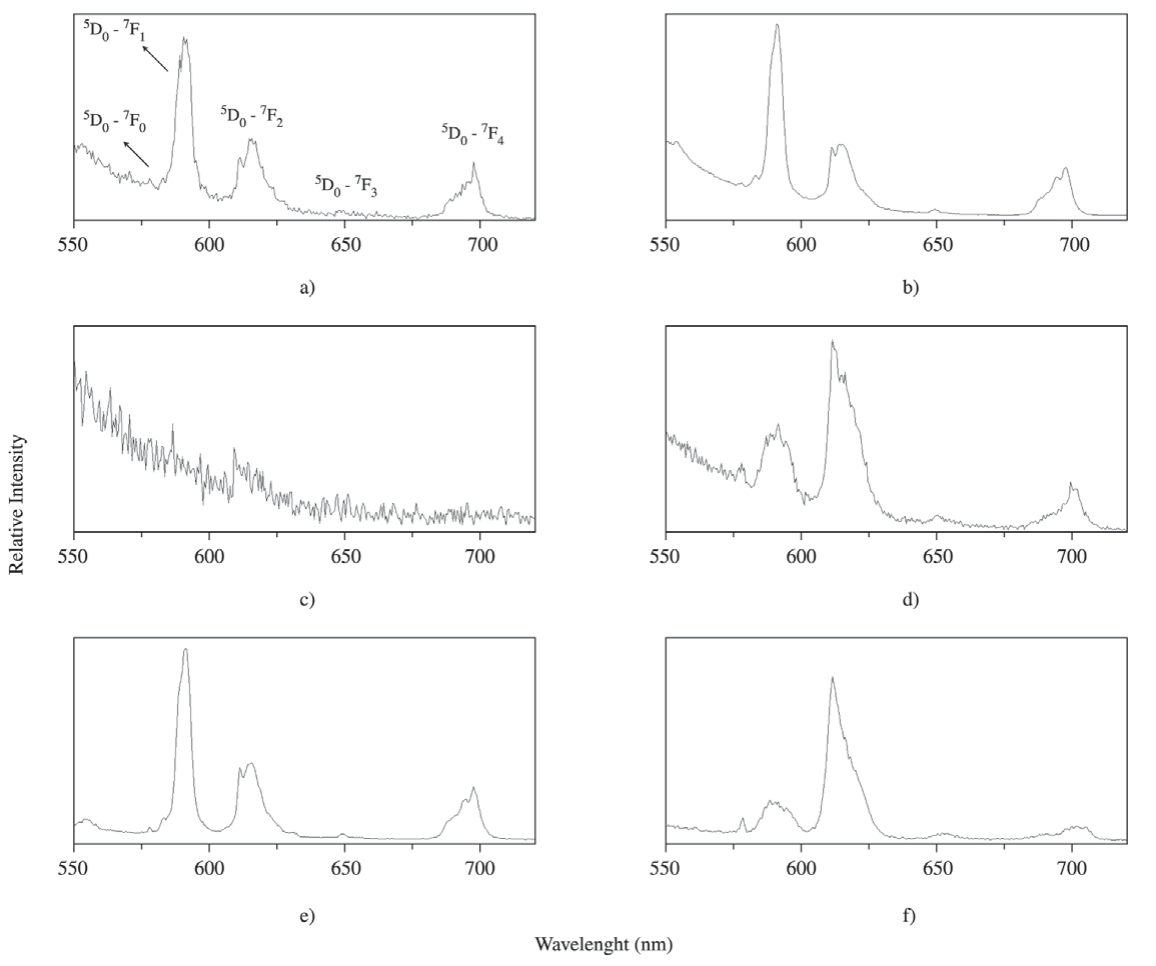
λ = 393 nm; b) TEOSEu(bpy)Cl 3 exc λ = 320 nm; f) TEOSAPTSEu(bpy)Cl 3 exc